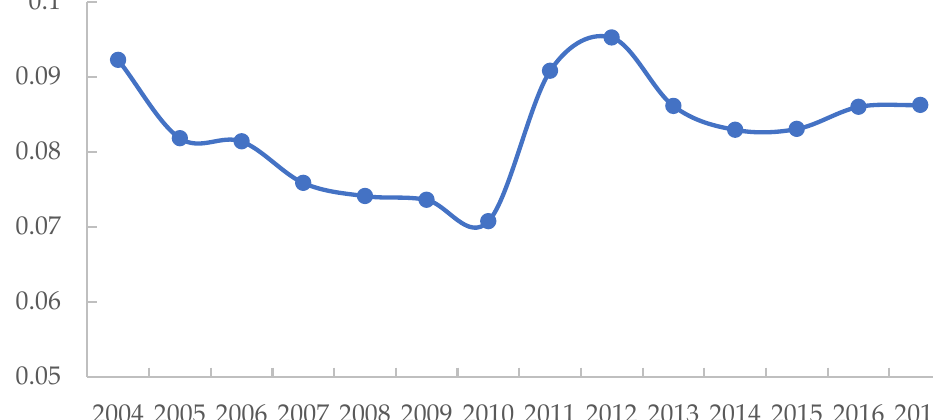
Figure 3. Average change trend of the green development level.